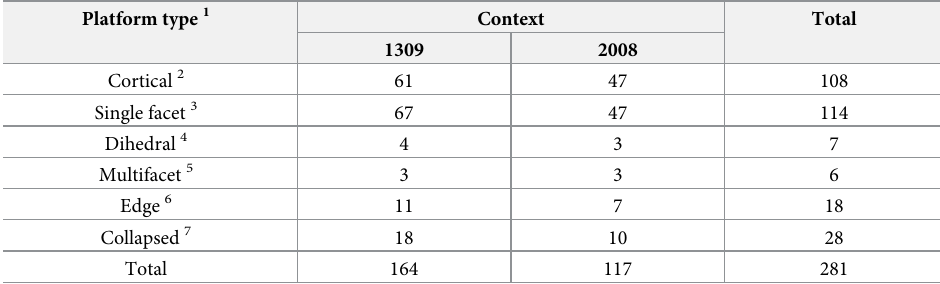
Table 3. Platform types on core reduction flakes, Horizon IV, Saruq